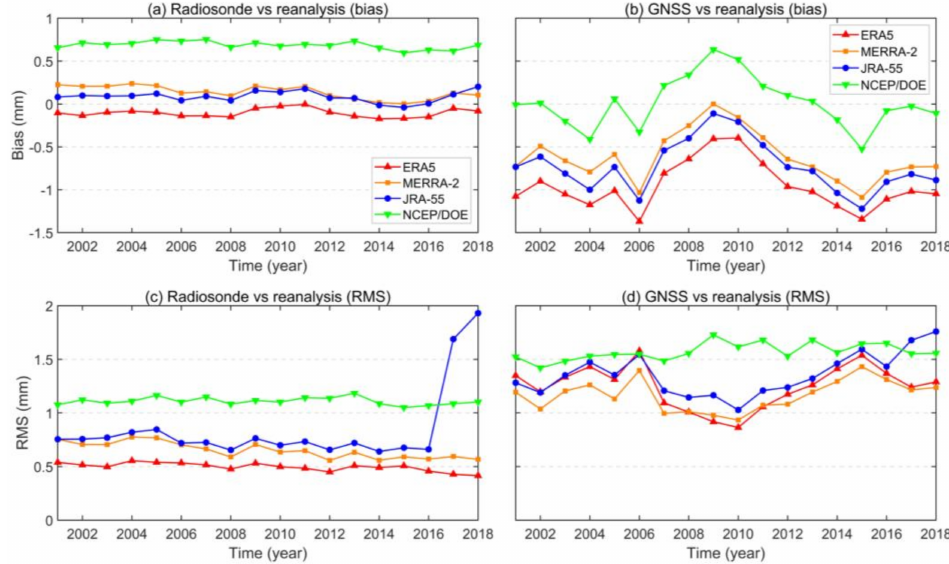
Figure 7. The ( a , b ) biases and ( c , d ) RMS errors of PWV differences between (left) radiosonde and four reanalyses, and (right) GNSS and four reanalyses for each year from 2001 to 2018. 4. PWV Means, Variability and